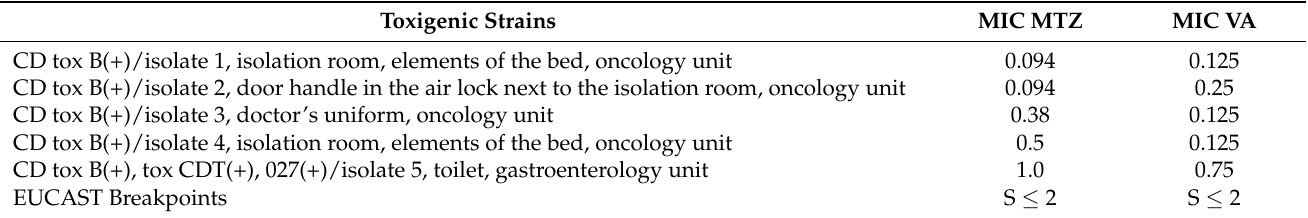
Table 4. Susceptibility of toxigenic C. difficile strains to metronidazole and vancomycin. Toxigenic Strains MIC MTZ MIC